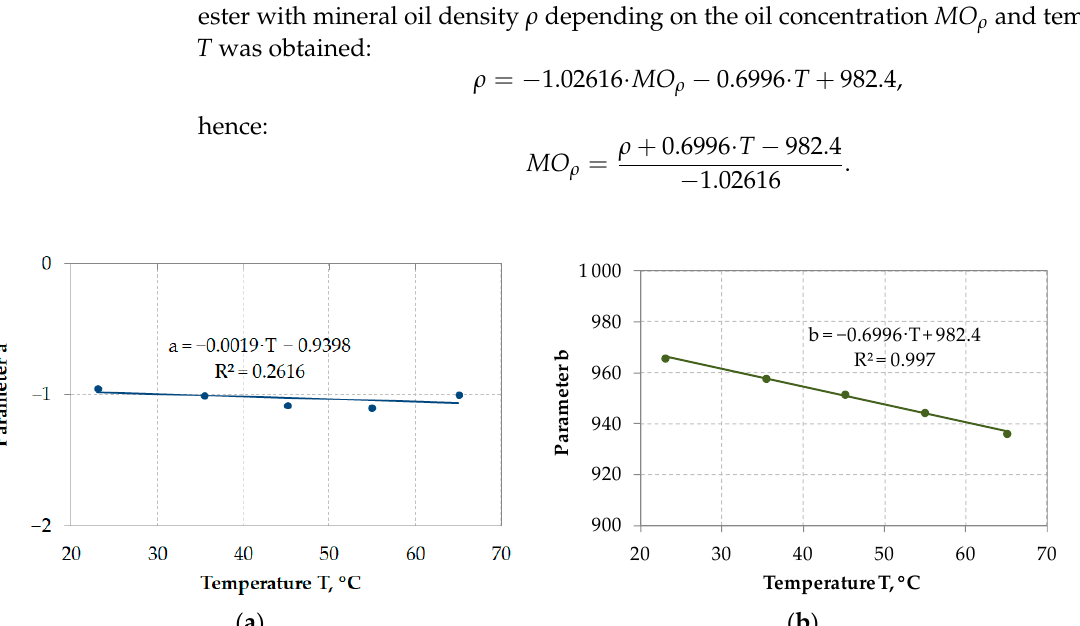
Figure 4. Parameters a ( a ) and b ( b ) depending on temperature (measurements of mixture density).